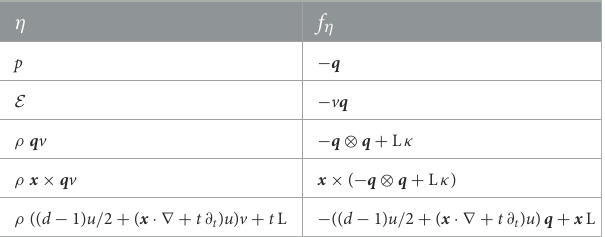
TABLE 2 Conservation laws for the scalar quantity η , deduced from the scalar wave